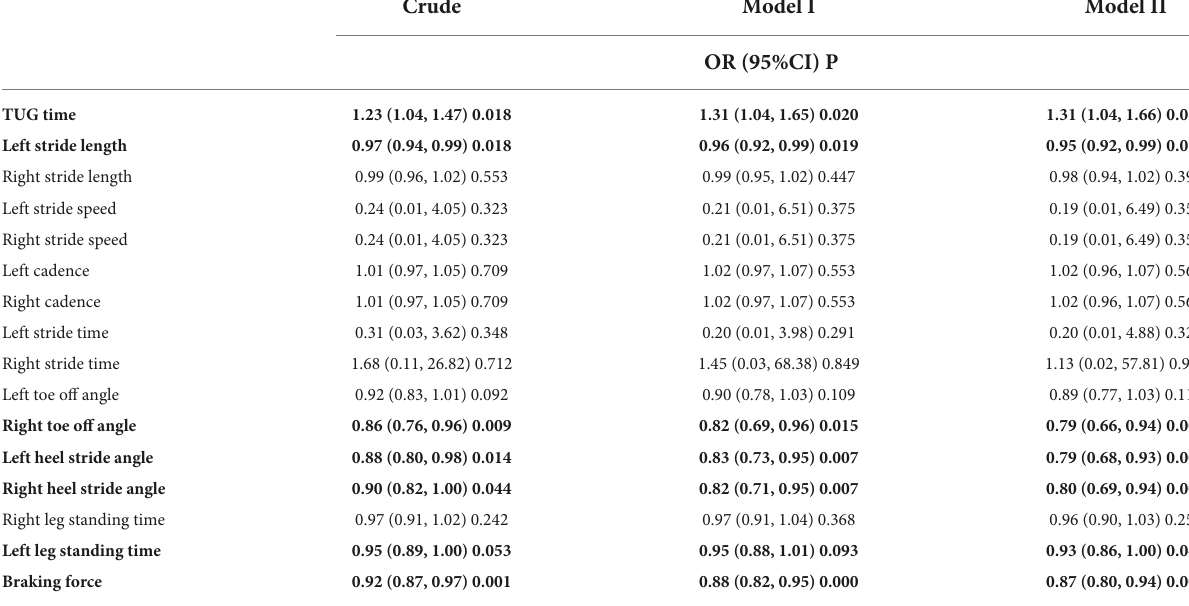
TABLE 2 Regression analyses for kinematics parameters and amnestic mild cognitive impairment (aMCI).